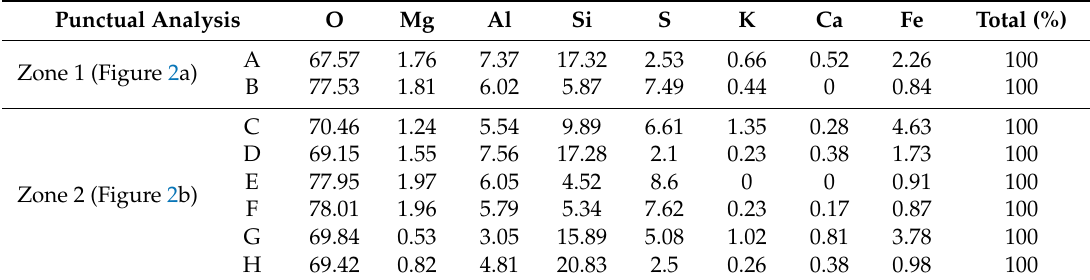
Table 1. Energy Dispersive X-ray Spectroscopy (EDS) results in wt % MT-KSF sample.